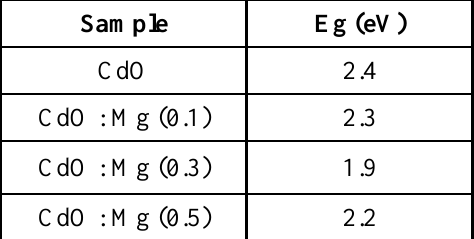
Fig.6: Represents a pure optical power gap with magnesium tainted by different vaccination ratios. Table 3: The values of the optical energy gap of pure (magnesium-doping) CdO